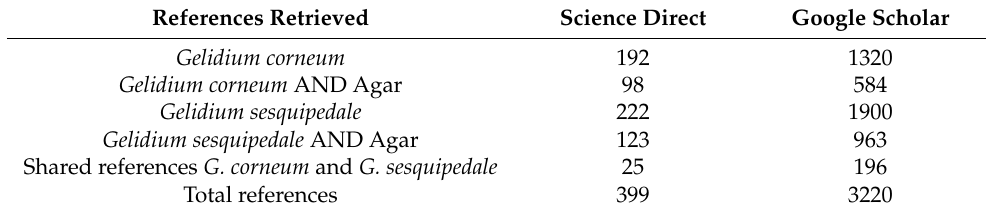
Table 1. References retrieved from Science Direct and Google Scholar for Gelidium corneum and the synonym Gelidium sesquipedale